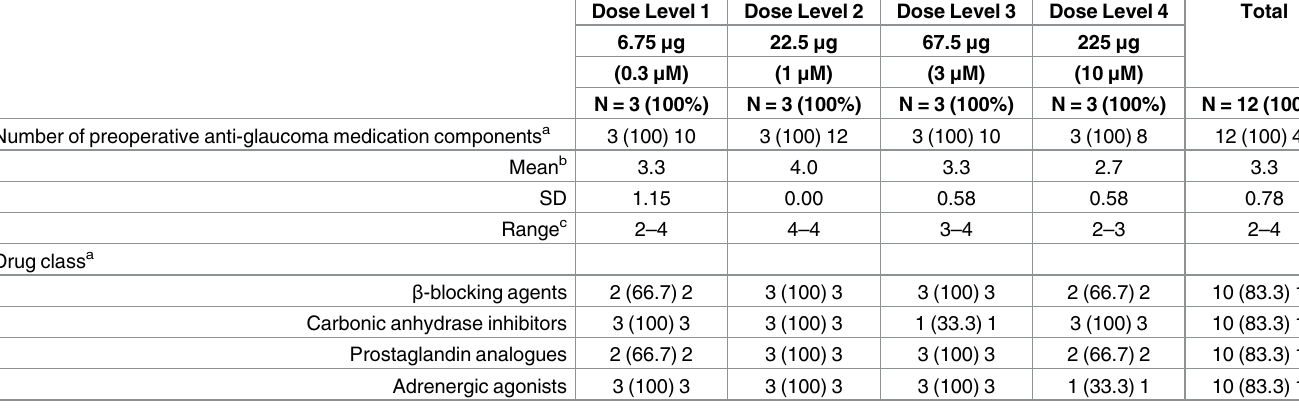
Table 2. Preoperativeanti-glaucoma